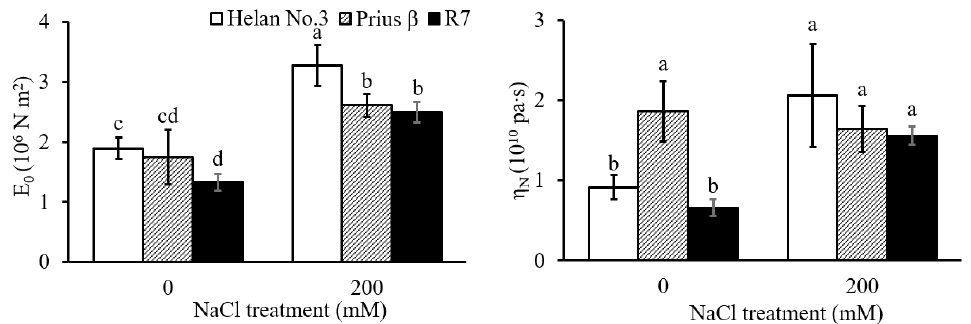
Figure 2. Elastic moduli (E 0 ) and viscosity coefficient ( η N ) of the root cell wall in the elongation zone in Helan 3, Prius β and R7 in 0 and 200 mM NaCl treatments. Data are mean ± S.E. ( n = 15–24). Different letters indicate significant differences ( p < 0.05).